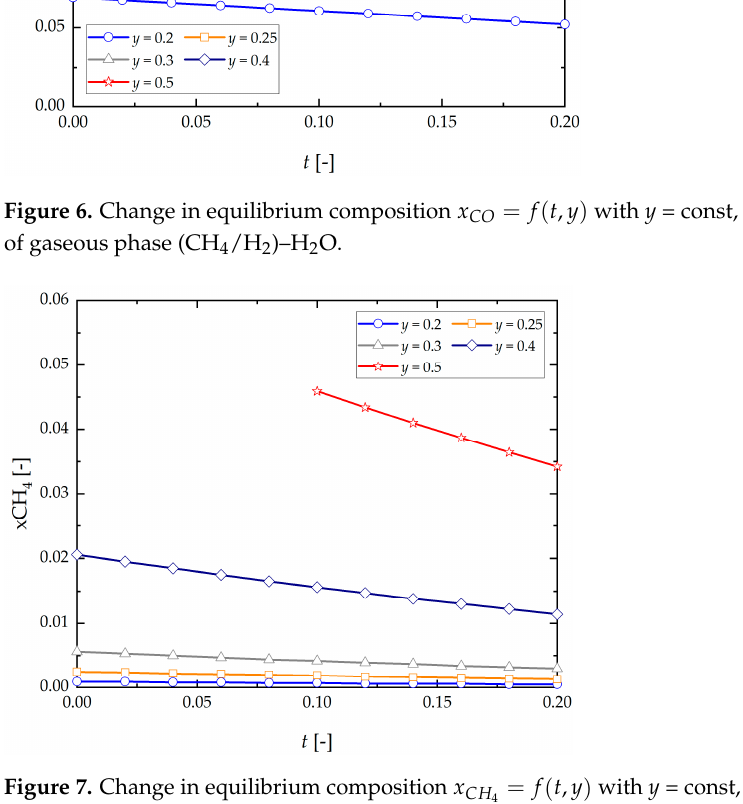
Figure 7. Change in equilibrium composition x CH of gaseous phase (CH 4 /H 2 )–H 2 O.